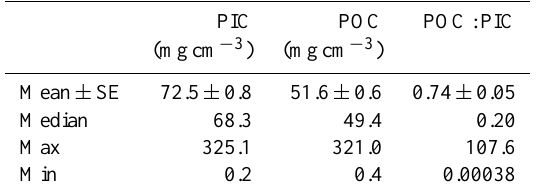
Table 2. Mean ± standard error (SE), median, minimum and max- imum values of particulate inorganic carbon (PIC), particulate or- ganic carbon (POC) and the estimated POC:PIC ratio for the data set where both POC and PIC were reported (392 sites; n = 3076). PIC POC